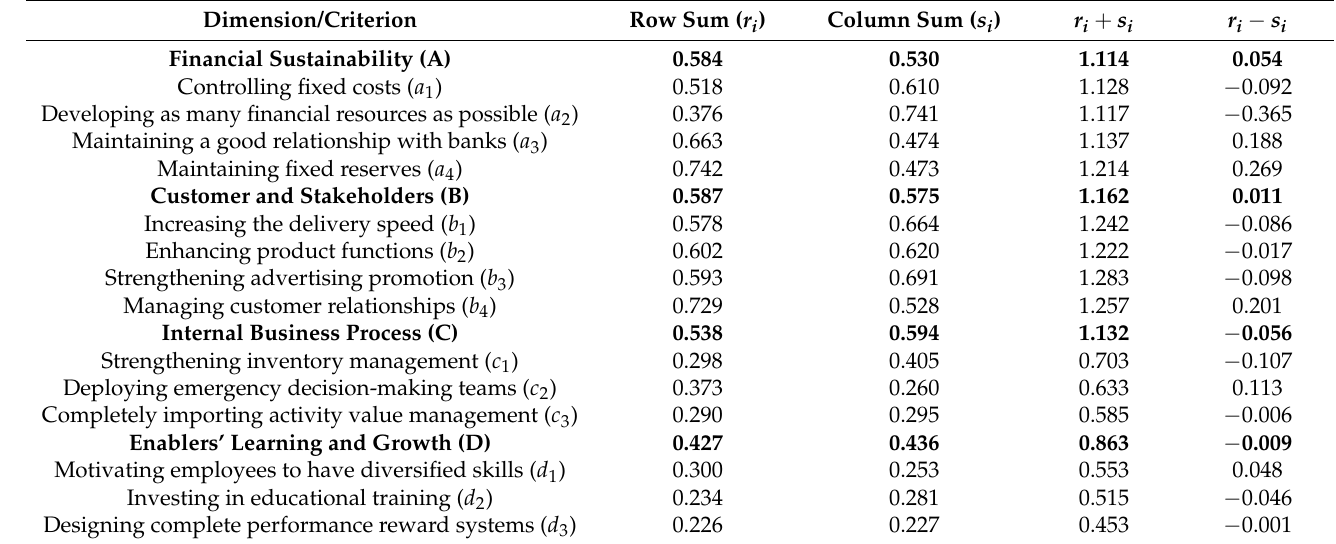
Table 9. Sum of cause r i and effect s i influences among the core dimensions and